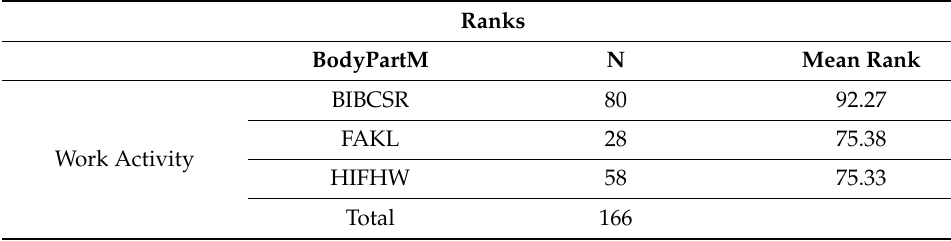
Table 8. Hypothesis test summary.